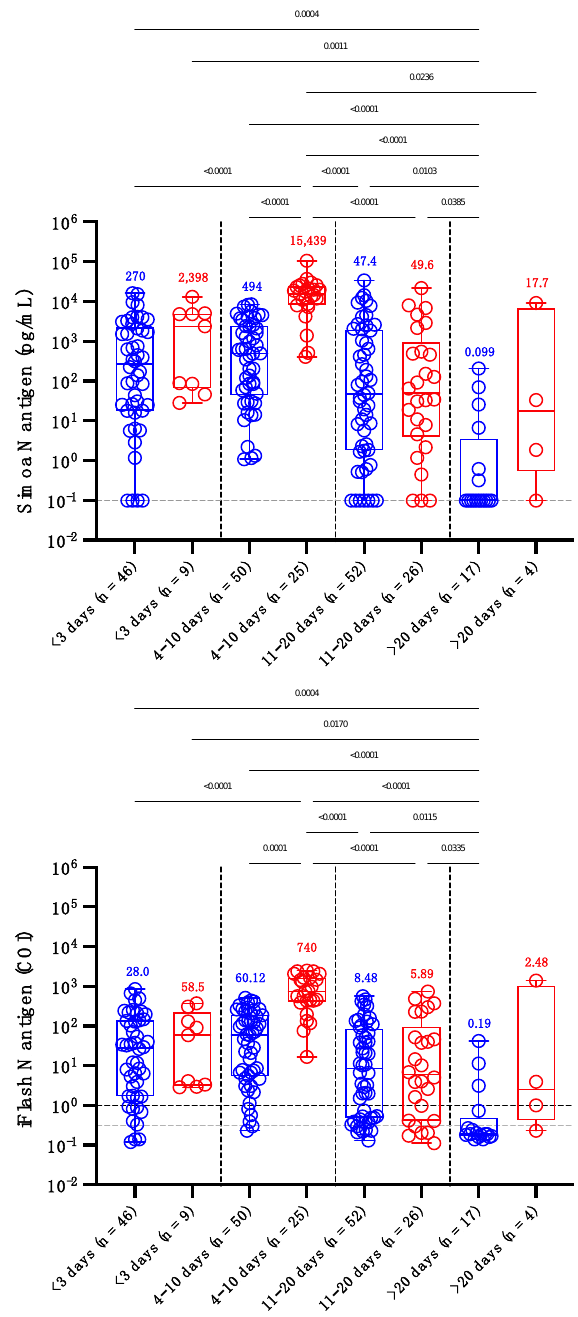
Figure 3. Levels of serum antigen according to the delay since the onset of symptoms (<3, 4–10, 11–20 and >20 days) and severity. Blue dots correspond to non-severe patients and red dots to severe patients. The grey dotted lines correspond to the positivity cut-off of each antigen assay, as found by ROC curve analyses. The black dotted line corresponds to the positivity cut-off of the iFlash assay, as declared by the manufacturer. Medians are represented on top of each whisker box. Only p -values < 0.05 are